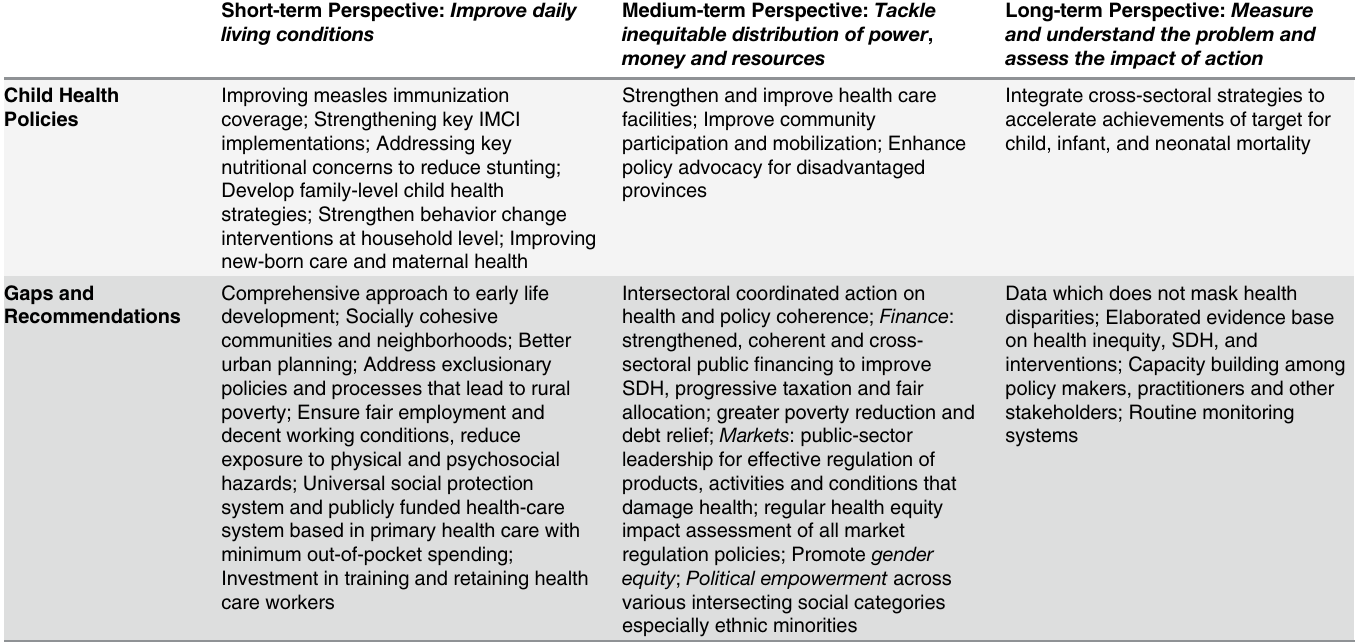
Table 6. Short, medium, and long-term policies and efforts to accelerate improvements along the five key determinants of child health inequities and for closing the gap in child health in Indonesia. Short-term Perspective: Improve daily Medium-term Perspective: Tackle living conditions inequitable distribution of power , money and